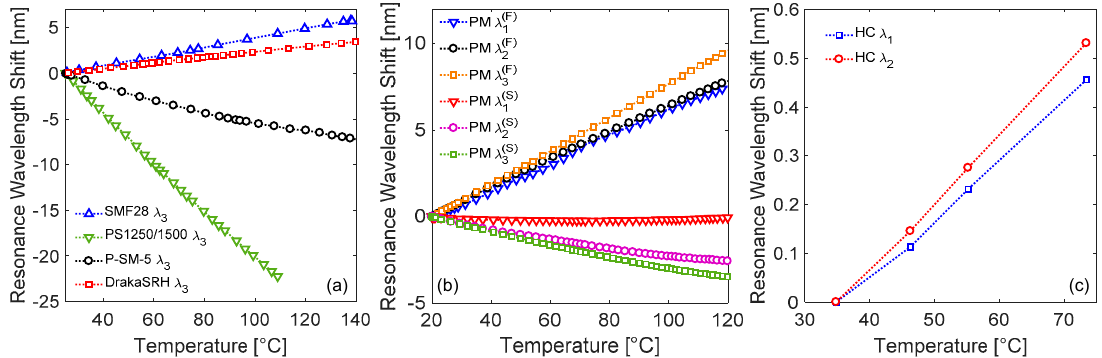
Figure 9. Resonance wavelength shifts towards temperature for LPGs in: ( a ) solid silica fibers with different dopants; ( b ) polarization-maintaining Panda fiber; ( c ) Hollow-core fiber. Table 2. Temperature sensitivity of LPGs.